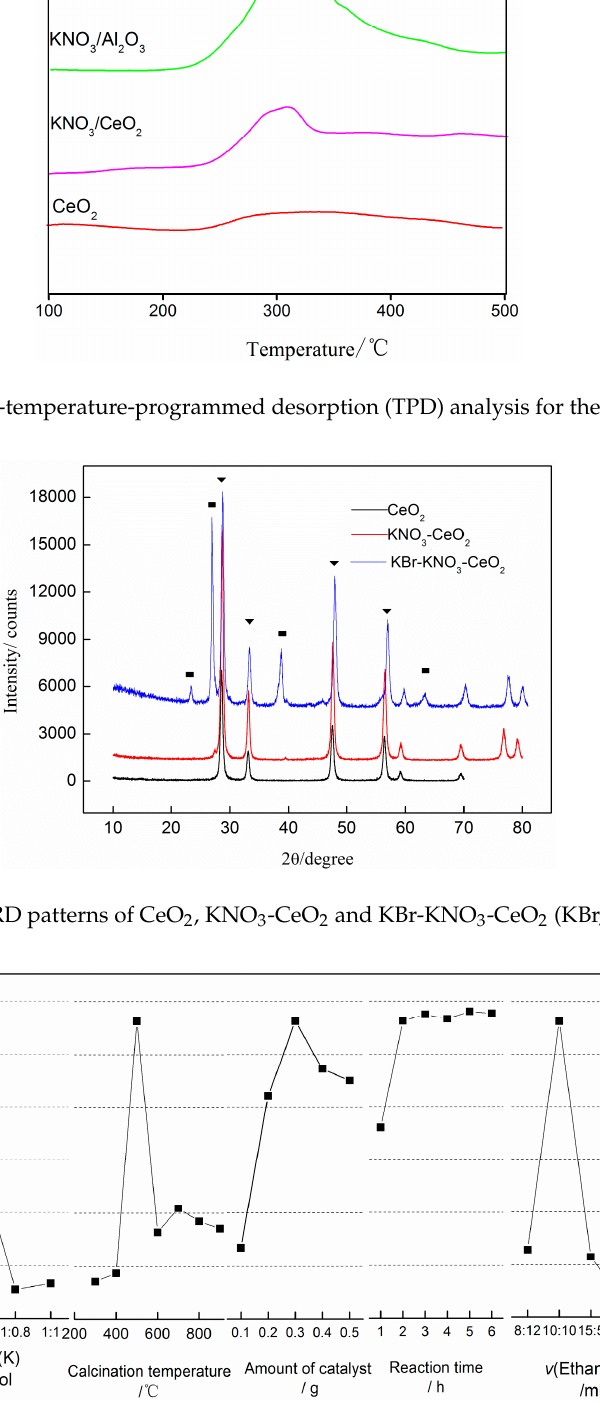
Figure 3. Optimization of the conditions for the catalyst preparation and the DEC synthesis. The ethanol volume was fixed as 10 mL; the reaction temperature was 150 °C; and the initial pressure was 5 MPa.